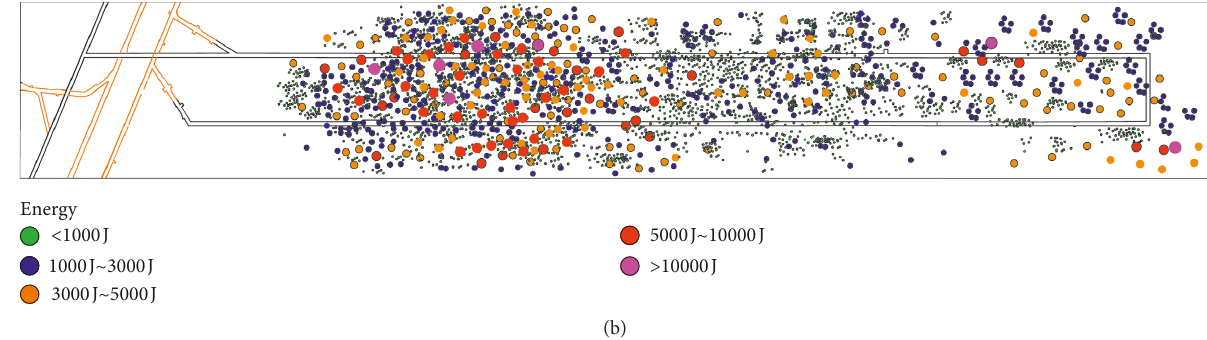
Figure 13: Energy distribution of microseismicity during mining. (a) No. 9301 backfill mining working face. (b) No. 1303 caving mining working face. Table 2: Statistics of microshock during extraction of 9301 and 1303 workface Number of microseismic events from No. 9301 Number of microseismic events from No. 1303 Energy range backfill mining working face fully mechanized mining face